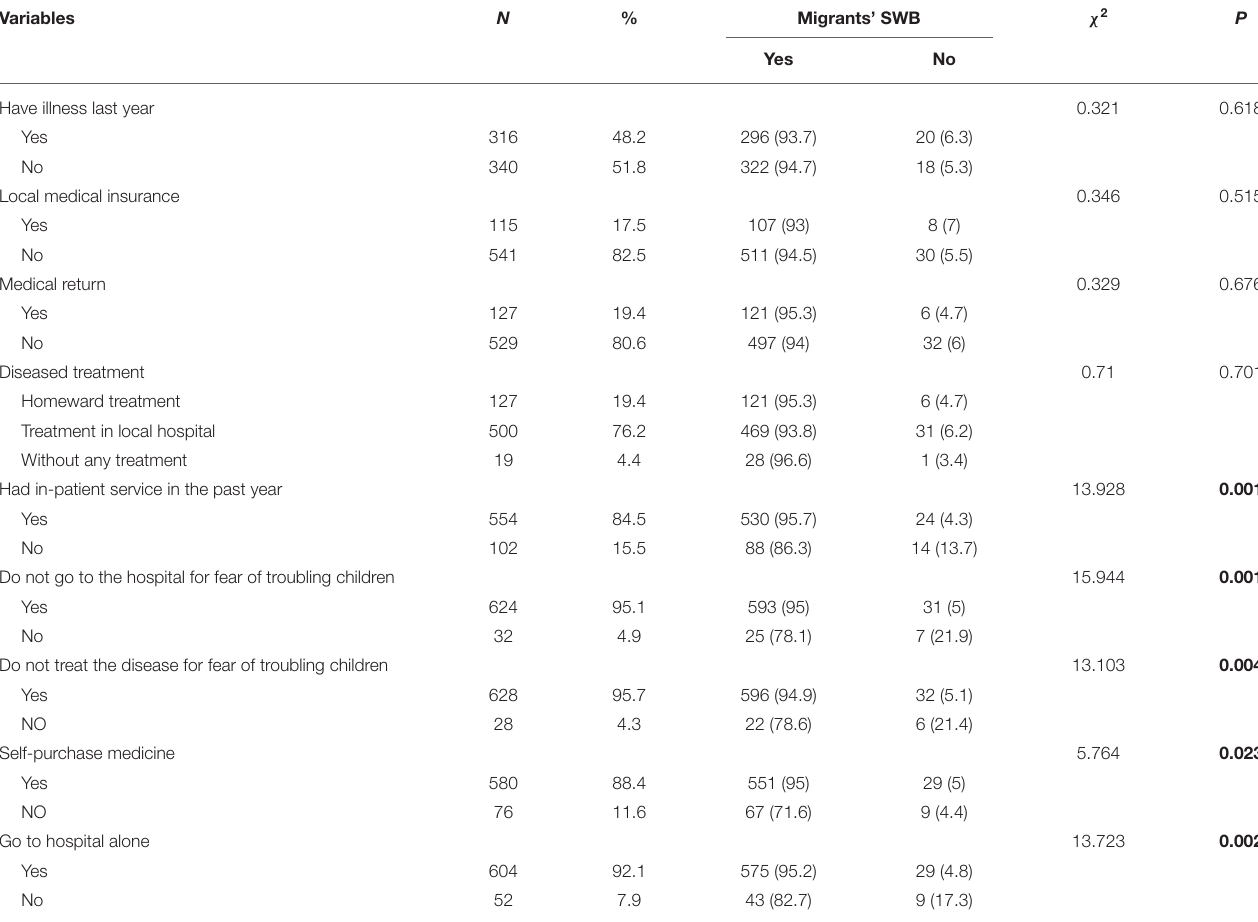
TABLE 4 | Utilization of medical and health services of migrant elderly following their children. Variables